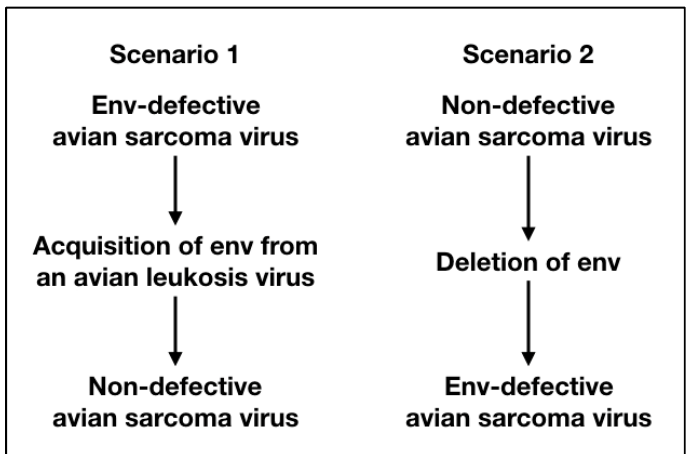
Figure 1. The figure summarizes the two possible genome versions of the original viral isolate of Peyton Rous and their subsequent evolution..